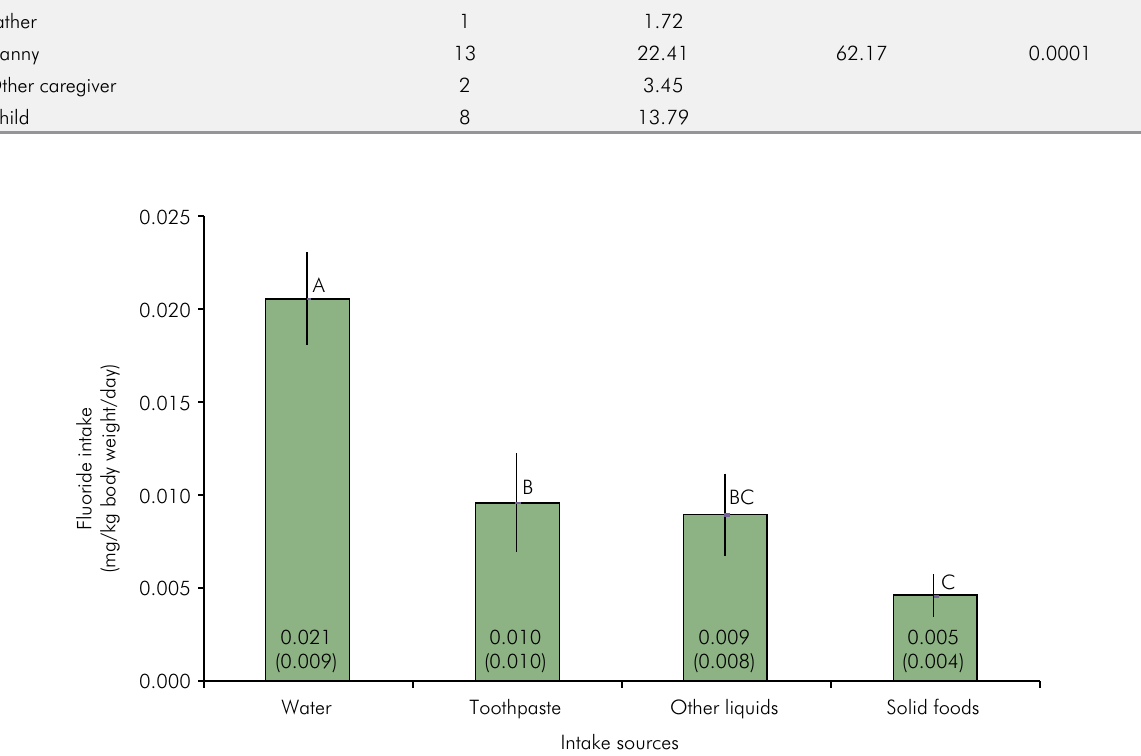
Figure. Mean (SD), confidence intervals (95%), and Tukey’s post test to compare the fluoride intake. Bars with the same letter are not significant (p >